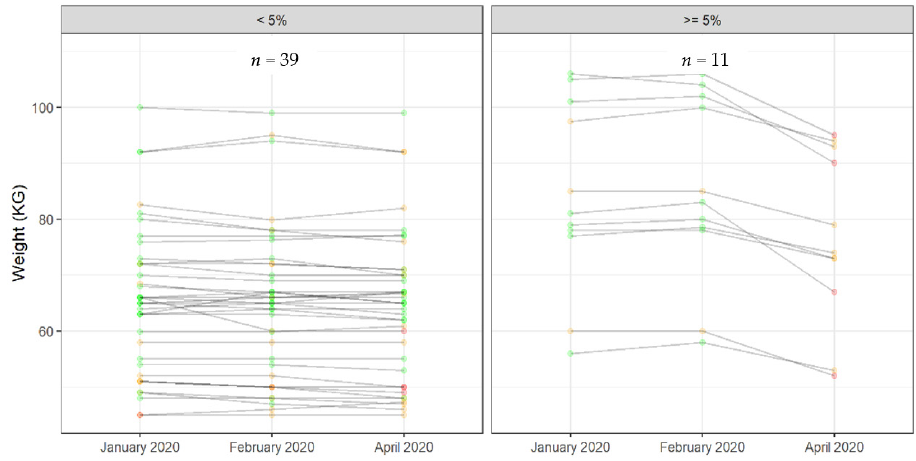
Figure 4. Individual weight variation <5% and ≥ 5% after lockdown.